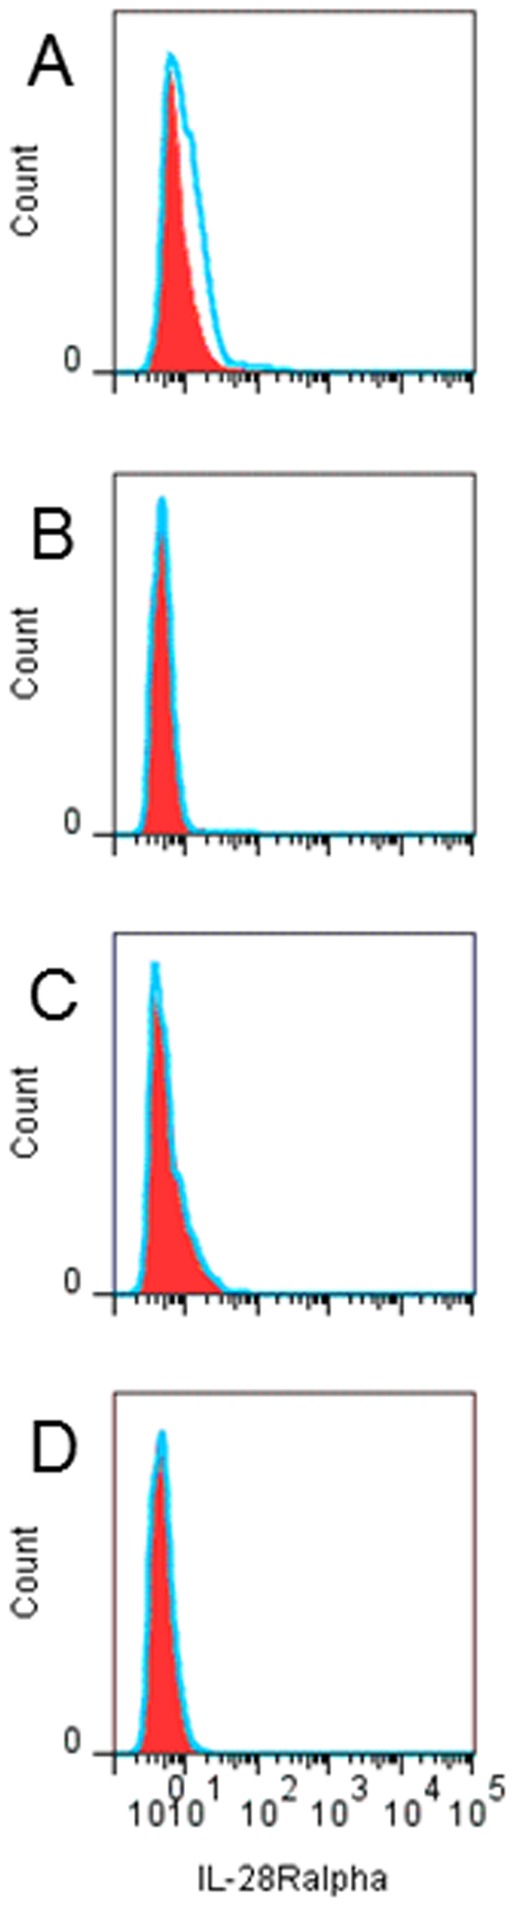
CD4+ T-cells do not express IL-28Ralpha.Resting or activated cord blood mononuclear cells were analyzed for IL-28Ralpha expression using FACS. IL-28Ralpha expression (histograms) on pDC (A) or CD4+ T-cells obtained directly upon isolation (B) or after 24 h incubation with anti-CD3 (C) or recombinant human IFN-alpha (D). Filled red areas represent isotype-PE control and blue lines represent IL-28Ralpha-PE.